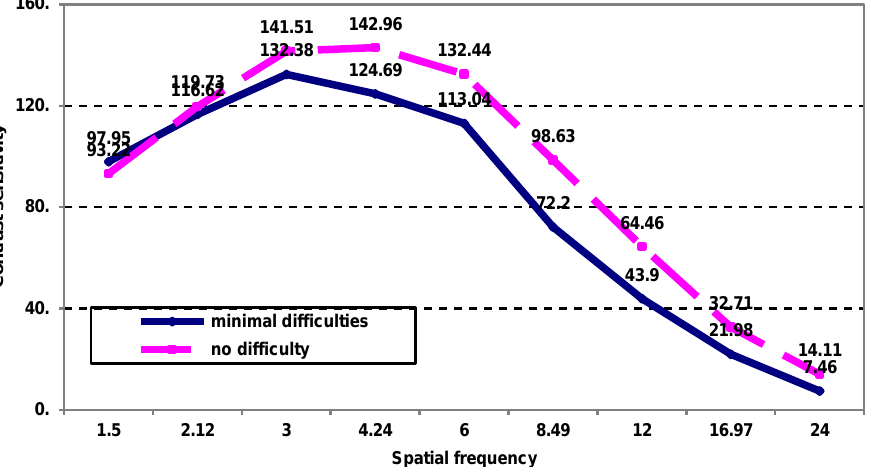
Figure 2. The contrast sensitivity as a function of spatial frequency in patients who have minimal post-treatment visual difficulties in reading prices .